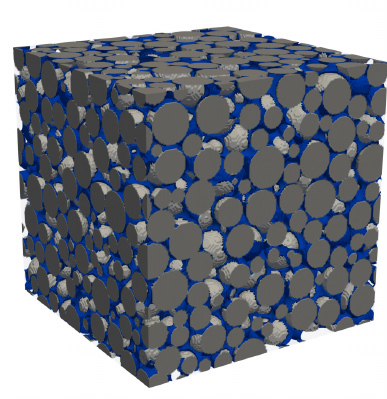
Figure 2. 3D view of the multiphase domain with η = 0.40 at S r = 0.4.